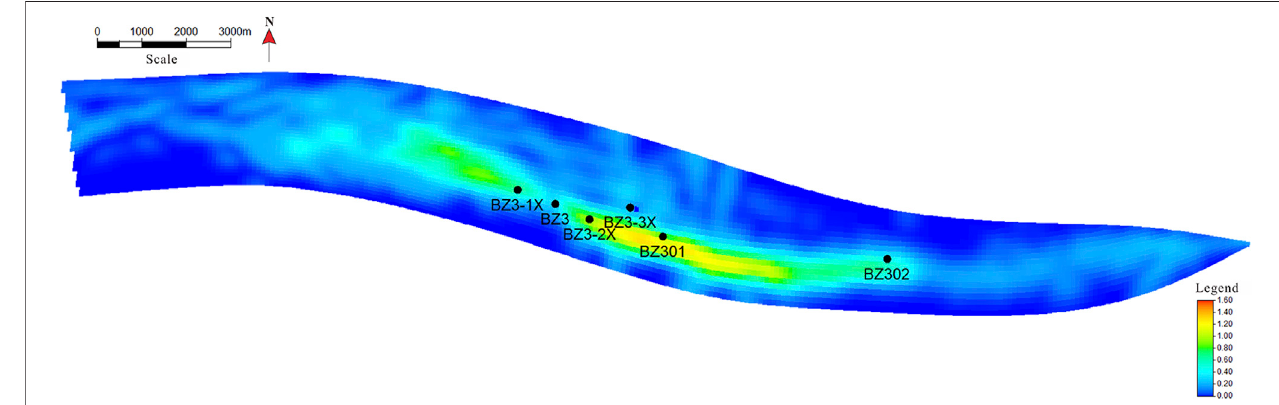
FIGURE 9 | Fracture intensity distribution of Bozi 3 gas reservoir.